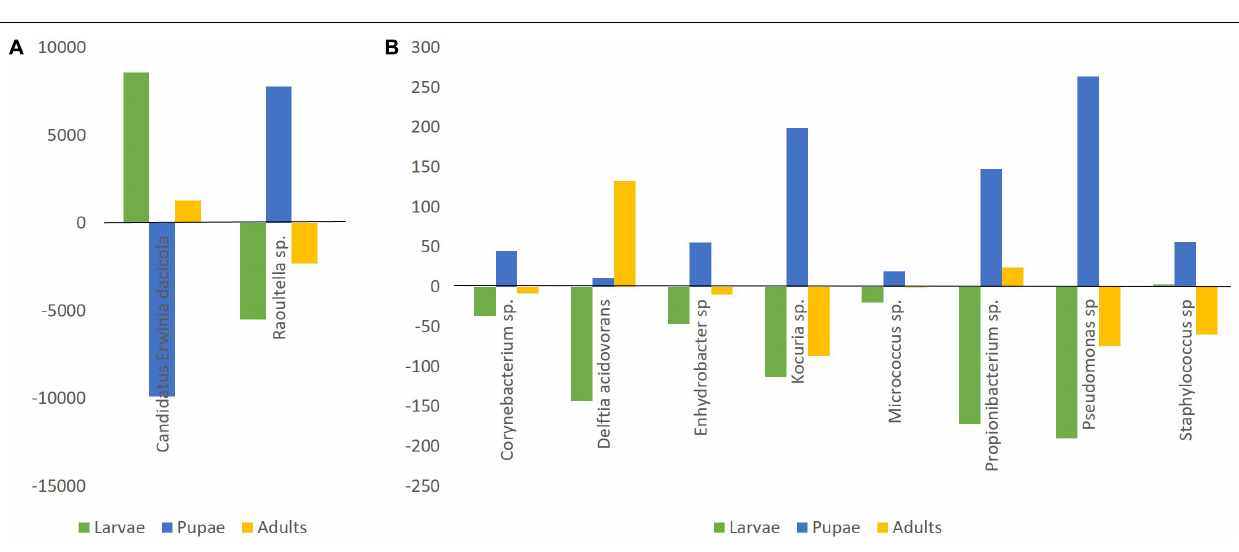
FIGURE 5 | The number of reads deviating from the average number per life stage of the 14 shared OTUs, grouped in 10 genera/species. (A) Candidatus Erwinia dacicola (average 69,078 sequence reads) and Raoultella sp. (average 5,506 sequence reads); (B) Corynebacterium sp. (average 41 sequence reads), Delftia acidovorans (average 241 sequence reads), Enhydrobacter sp. (average 51 sequence reads), Kocuria sp. (average 120 sequence reads), Micrococcus sp. (average 21 sequence reads), Propionibacterium sp. (average 228 sequence reads), Pseudomonas sp. (average 210 sequence reads), and Staphylococcus sp. (average